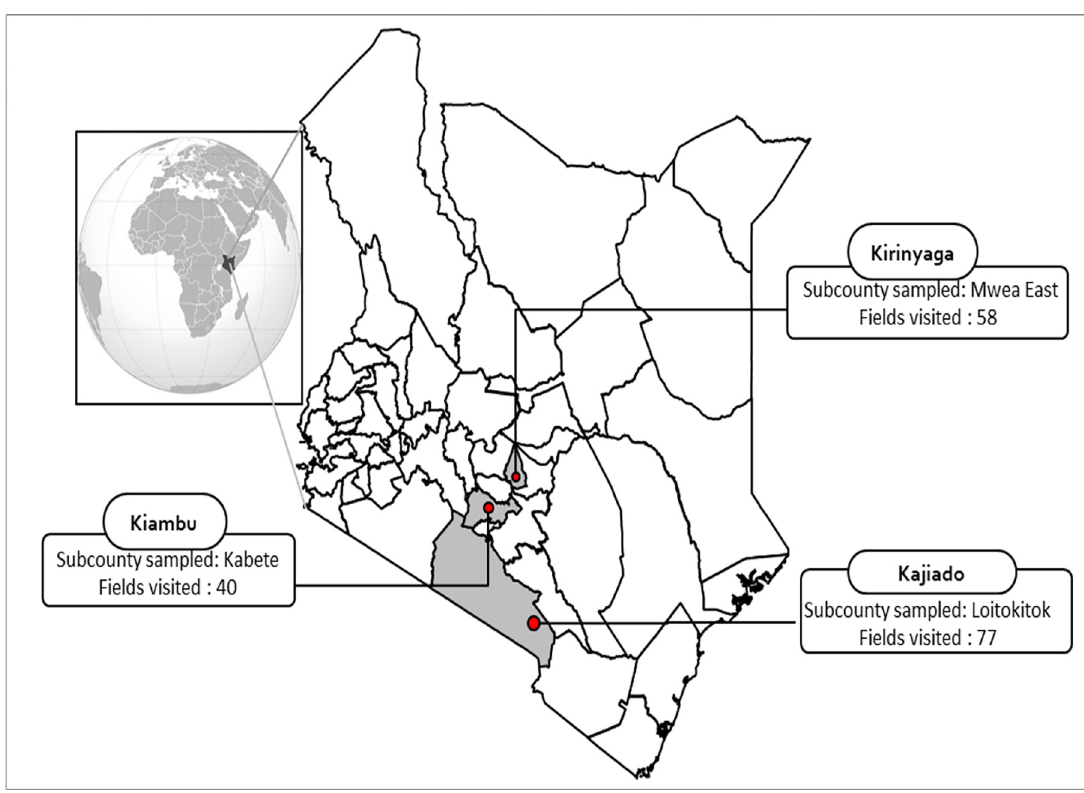
Fig 1. Map of Kenya showing location of study sites. (Developed for illustration purpose at http://yourfreetemplates.com).